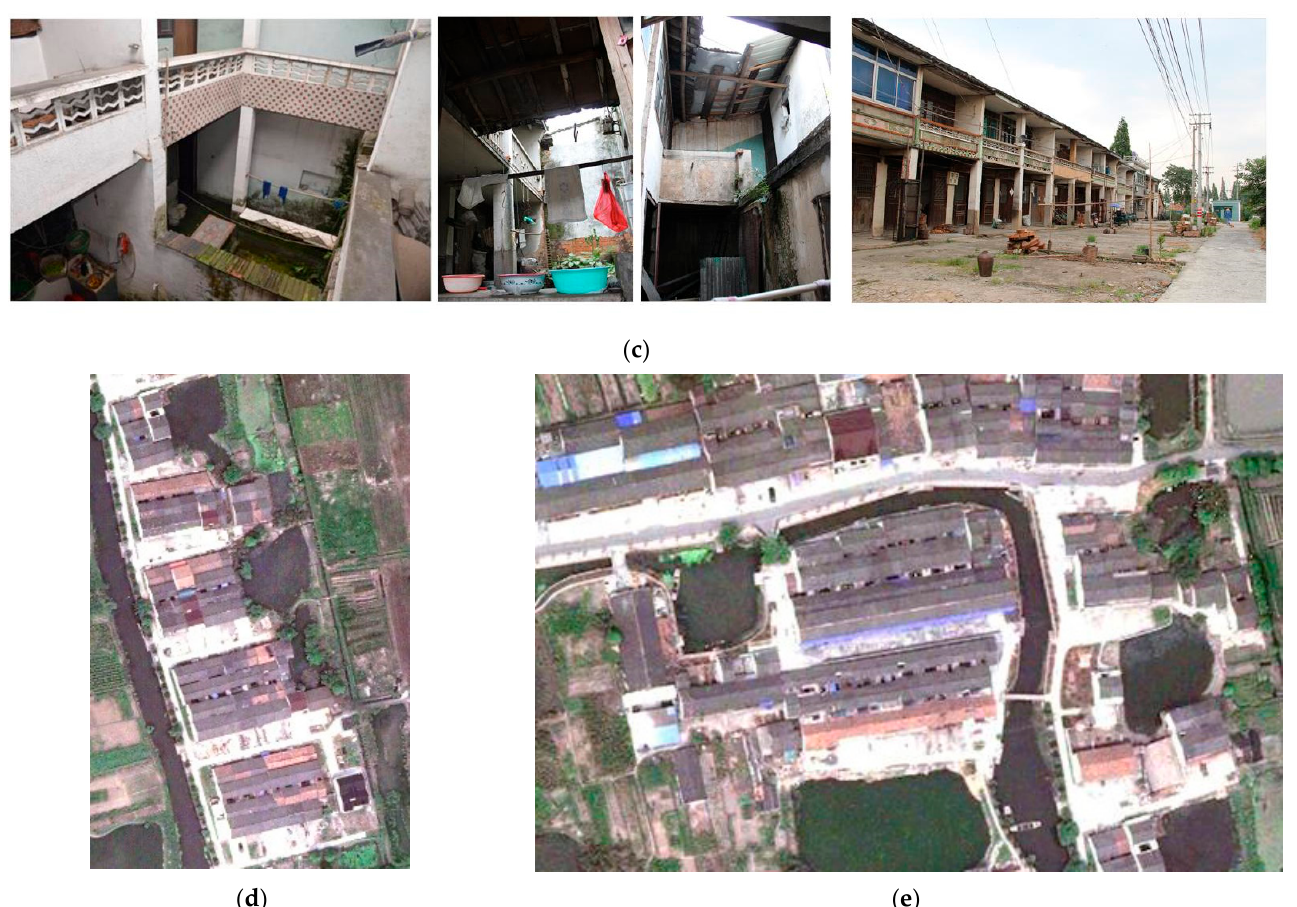
Figure 1. ( a , c ) Appearance of the traditional tubular houses; ( b ) a base case in a group arrangement of tubular houses; ( d , e ) Google map of the tubular houses (2021).